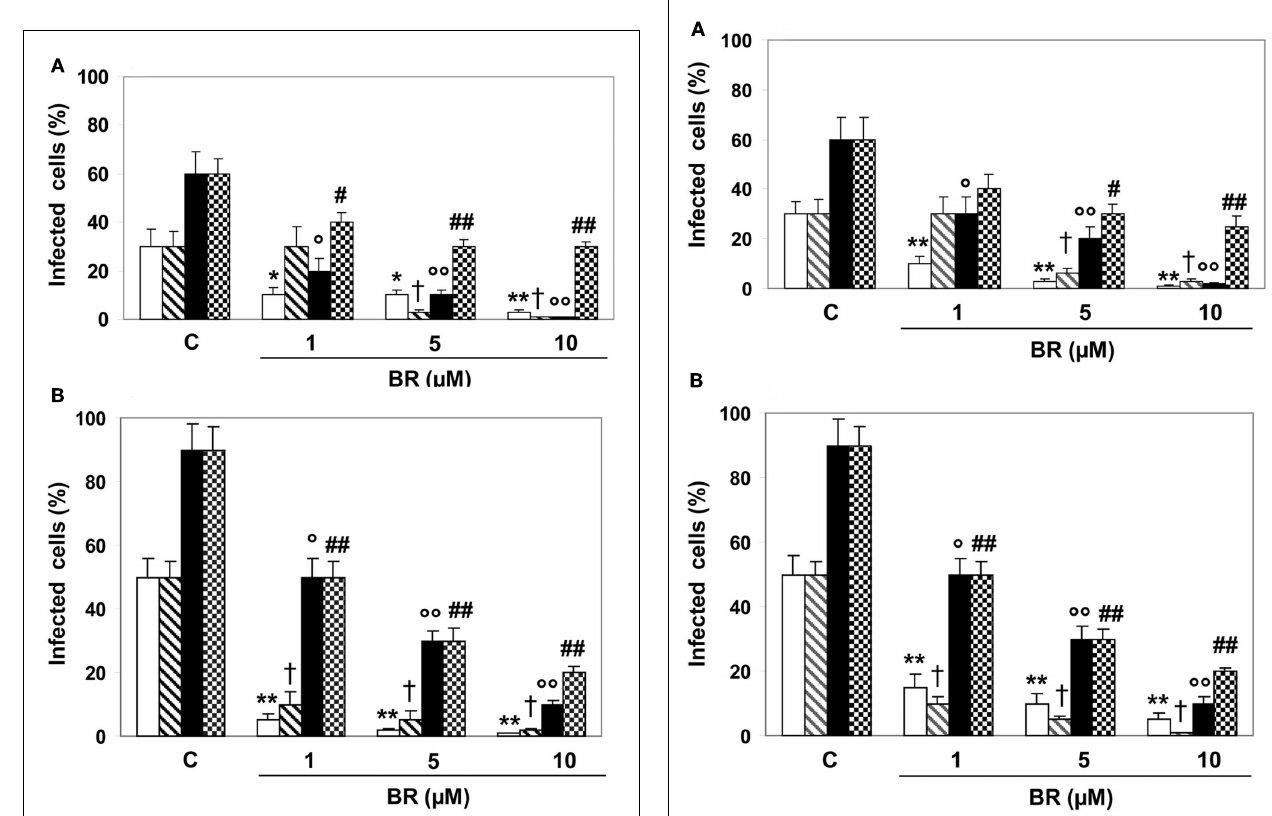
FIGURE 2 | Direct effect of bilirubin (BR) and albumin-bound bilirubin (BR–HSA) on herpes simplex virus type 1 (HSV-1) and enterovirus EV71 and how this affects viral replication. Both HSV-1 and EV71 (1 × 10 5 PFU) were pre-incubated with BR (1–10 μ M) alone or complexed with saturating HSA (20 μ M) for 1h and then transferred to Hep-2 (A) andVero (B) cell monolayers for the infection. After 2h, the inocula were removed and the cells incubated in culture medium for 24h (white and dashed columns) or 48h (black and dotted columns). Both dashed and dotted columns refer to HSA treatment as described in the Section “Materials and Methods.” Data are expressed as the percentage of infected cells, mean ± SEM of six individual samples per group. * P < 0.05 versus control (C) after 24h from infection; ** or † P < 0.01 versus respective controls after 24h from infection; ˚ or # P < 0.05 and ˚˚ or ## P < 0.01 versus respective controls after 48h from infection.